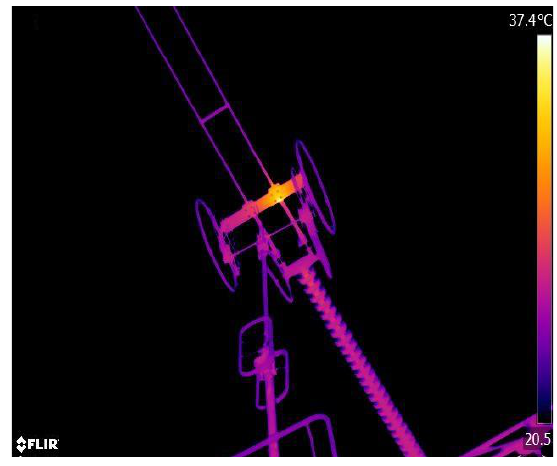
Figure 6. Infrared thermal image of an insulator in a power substation.